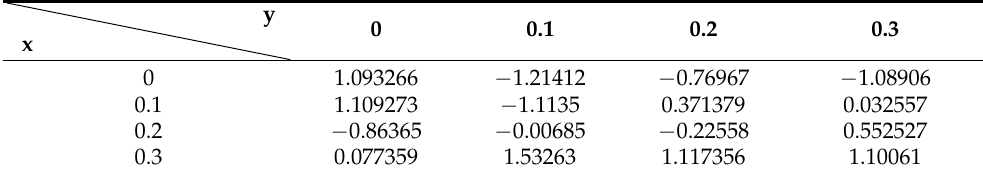
Table 1. Original two-dimensional discrete data.